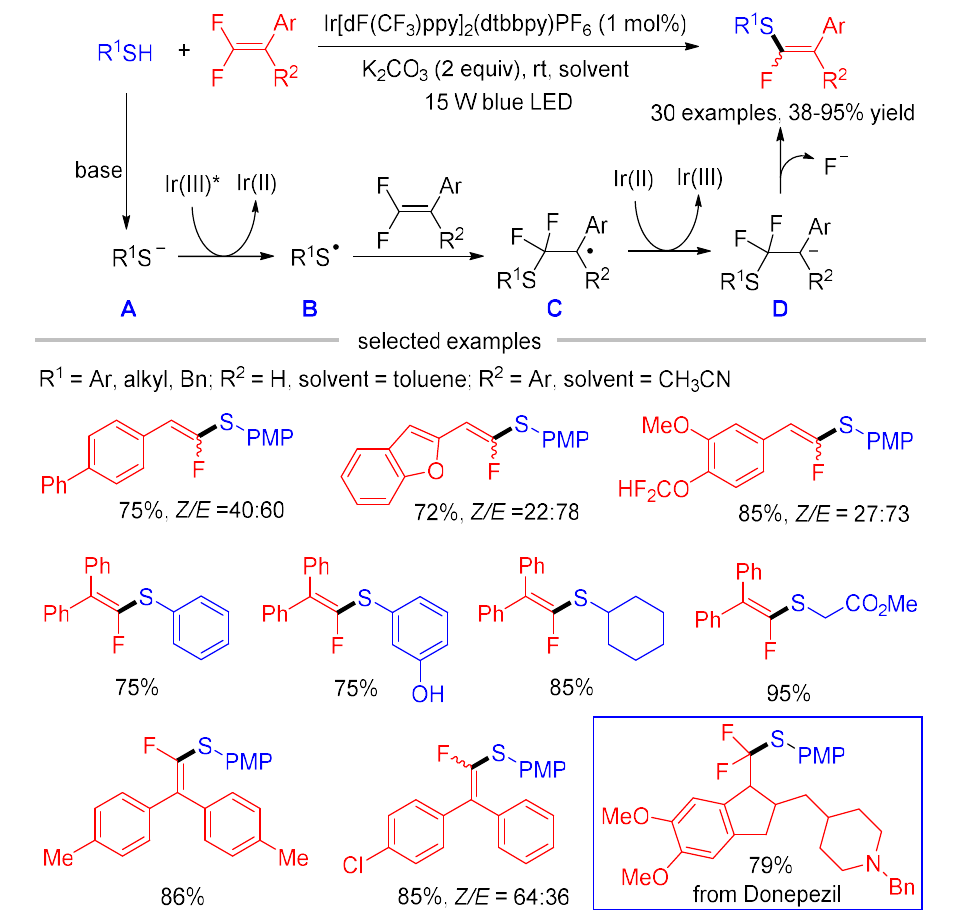
Scheme 15. Defluorinative cross-coupling of gem -difluoroalkenes with